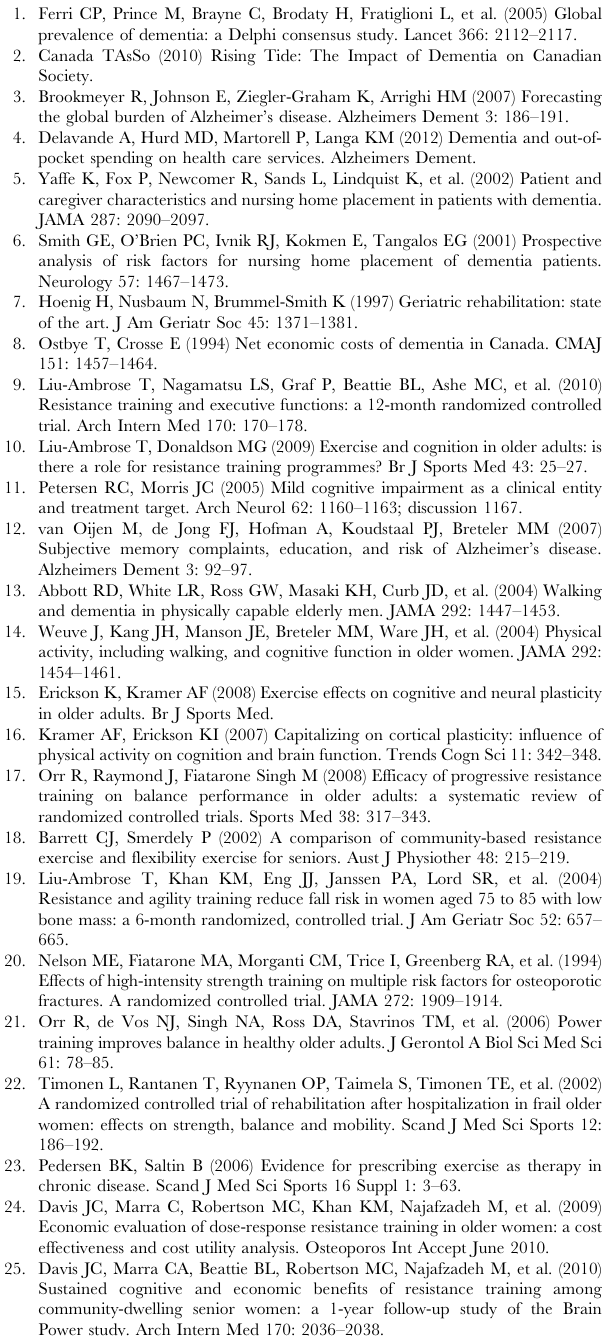
Table S1 Health resource utilization